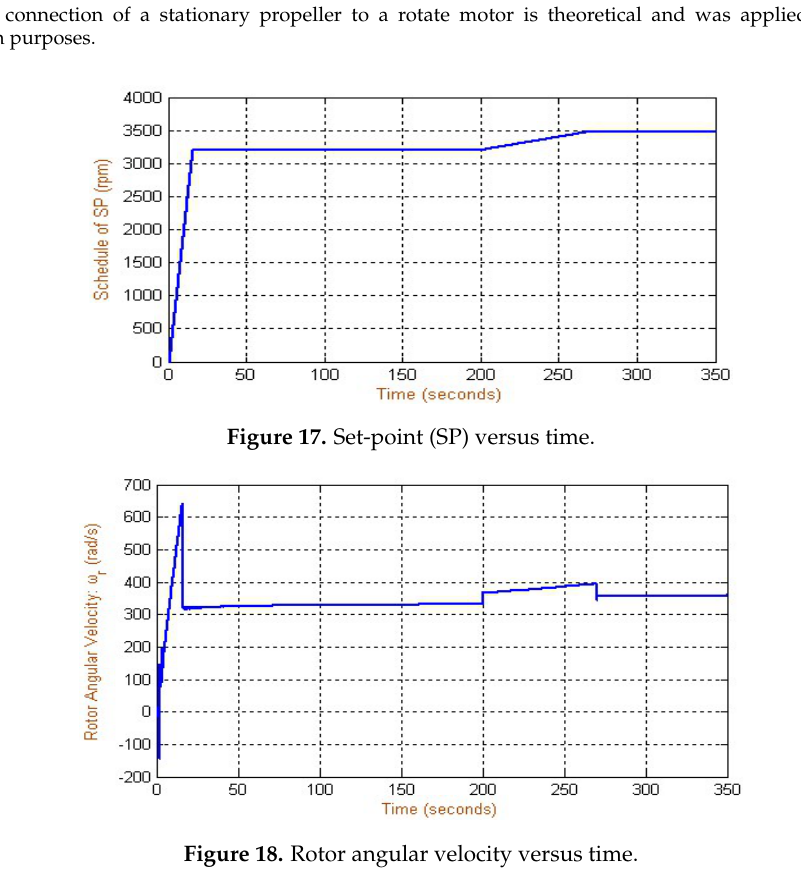
Figure 18. Rotor angular velocity versus time.